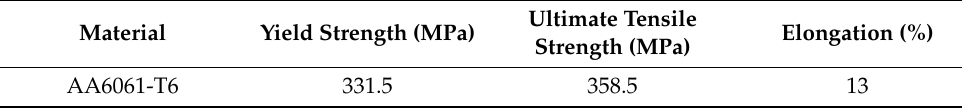
Table 2. Typical mechanical properties of